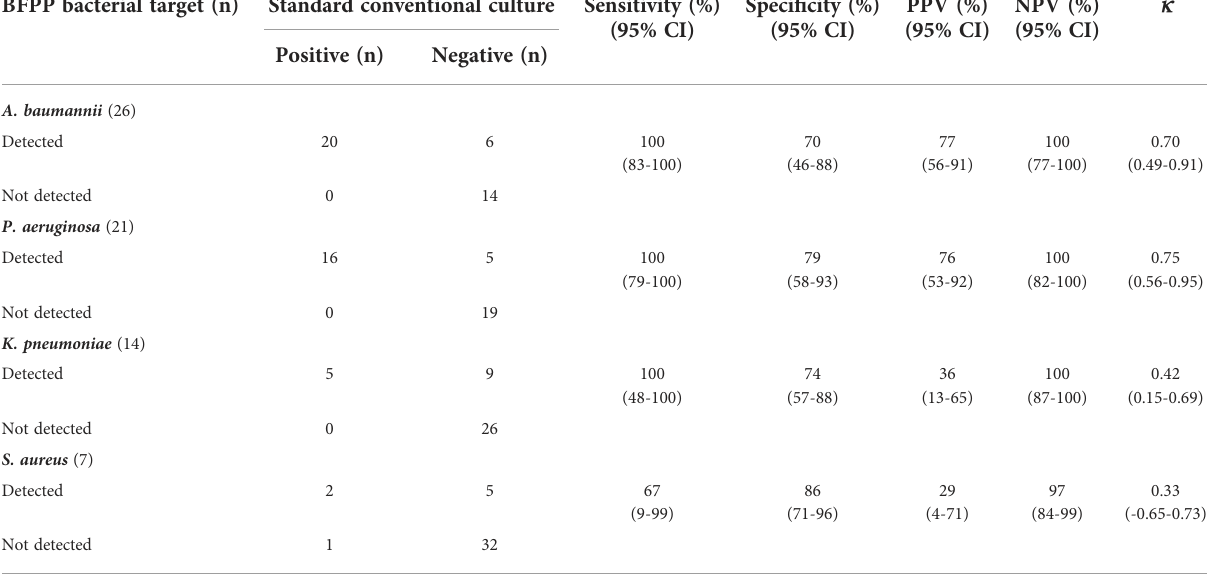
TABLE 4 Sensitivity, speci fi city, positive predictive value, negative predictive value, and Cohen ’ s kappa coef fi cient ( k ) of BioFire FilmArray pneumonia panel plus assay to detect common individual etiologies of hospital-acquired pneumonia and ventilator-associated pneumonia. BFPP bacterial target (n)